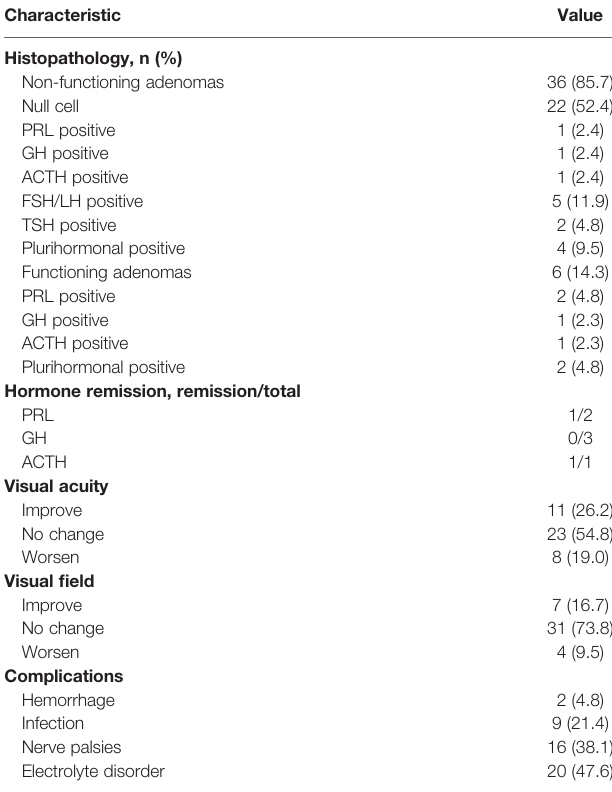
TABLE 5 | Clinical outcome and